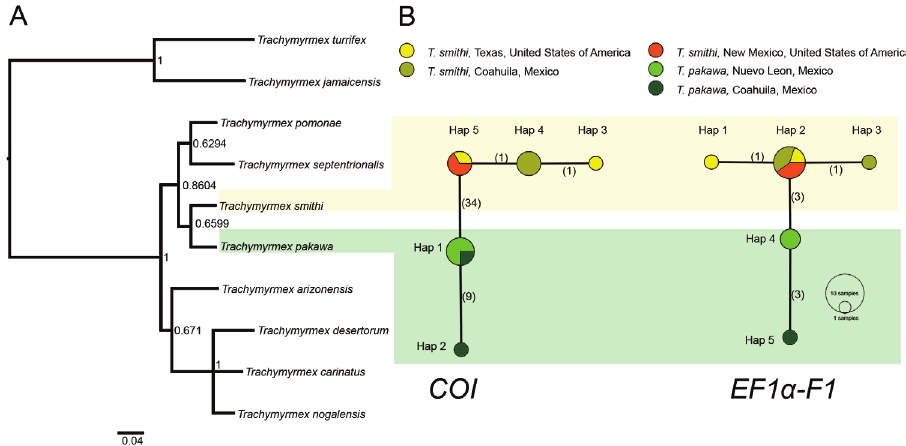
Figure 4. A Bayesian phylogenetics estimates and B haplotype networks of COI and EF1- α -F1 sequences of North American Trachymyrmex species. The phylogenetics inference was calculated with COI and EF1- α -F1 ; clade support is indicated above branch posterior probability by Bayesian inference. Due to the incomplete taxon sampling the tree was midpoint rooted. In the minimum-spanning haplotype networks for COI and EF1- α -F1 , each circle represents a haplotype, with size proportional to the haplotype’s frequency in the popu- lation. Numbers along branches represent